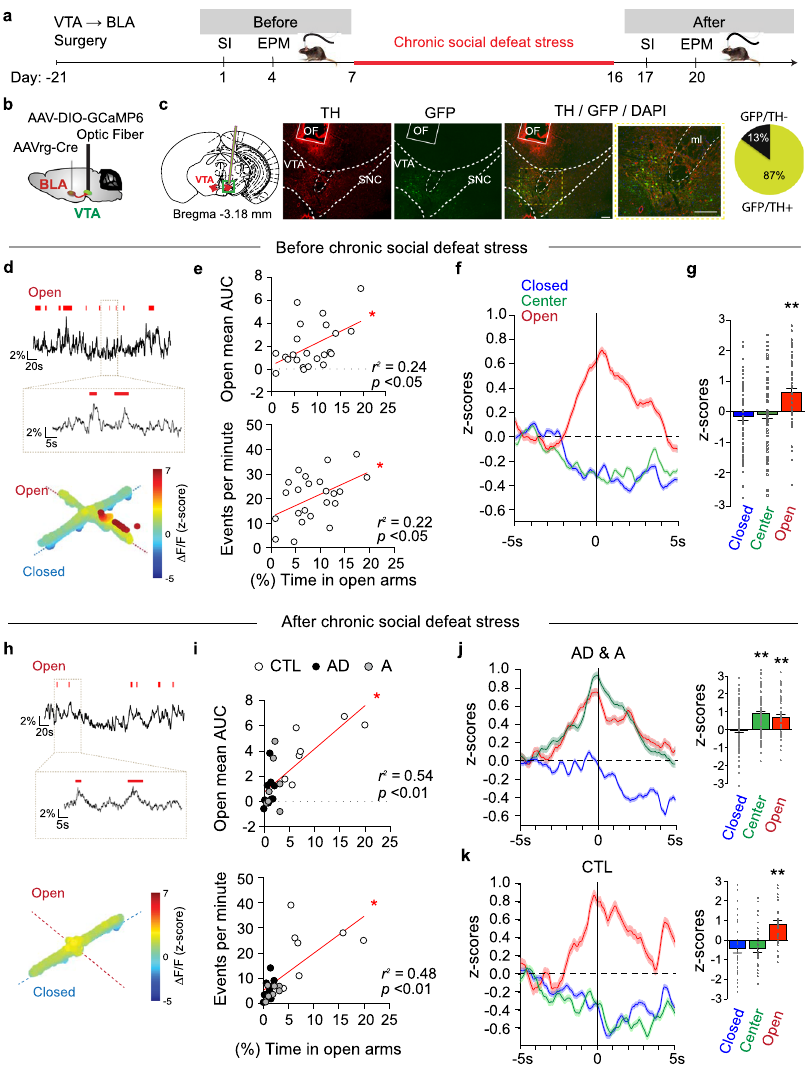
Fig. 3 Anxiety-like behavior is associated with the dynamics of VTA → BLA neurons. a Experimental timeline. b Schematic of the brain surgery targeting the VTA → BLA circuit. c Confocal image showing morphological validation of the placement of the optic fi ber (OF) above the VTA and the co-expression of TH labeling with AAVrg-Cre-eYFP X AAV-DIO-GCaMP6 in the C57BL6/J mouse VTA (scale bar, 100 μ m); quanti fi cation shows 87% colocalization (3 – 4 sections per mouse from 3 mice). d – g Before CSDS. d (Top) Sample traces of GCamp6 Δ F / F signal (bars represent the mouse in open arms). (Bottom) 3D representation of the GCamp6 Δ F / F upon the mouse position within the EPM. e Correlation analyses of the time spent in EPM open arms with (top, Pearson, p = 0.02) the mean open arms AUC VTA → BLA activity and (bottom, Pearson, p = 0.02) with the number of events per minute ( n = 23 mice, examined across 3 independent replicated experiments). f Dynamics of GCamp6 signal (mean z -scores ± s.e.m.) 5 s before and 5s after the mice enter EPM closed arms, center and open arms. g Averaged GCamp6 z -scores across stress-naïve mice within a 1-s bin ( − 0.5 to + 0.5 s) time-locked to EPM closed arms, center or open arms entries (mean ±s.e.m., ANOVA, F 2/276 = 10.94 p = 2.6e − 05; t = 4.32 p = 2.4e − 05; t = 3.88 p = 1.7e − 04, n = 80, 98,100 epochs). h – k After CSDS. h (Top) Sample traces of GCamp6 Δ F / F signal (bars represent the mouse in EPM open arms). (Bottom) 3D representation of the GCamp6 Δ F / F upon the mouse position within the EPM. i Correlation analyses of the time spent in EPM open arms with the mean open arms AUC VTA → BLA activity (top, Pearson, p = 0.001) and with the number of events per minute (bottom, Pearson, n = 23 mice, p = 0.0002). j (Left) Dynamics of GCamp6 signal (mean z -scores ± s.e.m.) 5 s before and 5 s after the socially stressed mice enter in EPM closed arms, center and open arms and (Right) related averaged GCamp6 z -scores across socially stressed mice within a 1-s bin ( − 0.5 to + 0.5 s) time-locked to EPM closed arms, center or open arms entries in socially defeated mice (mean± s.e.m., ANOVA, F 2/188 = 11.79 1.5e − 05; t = 4.71 p = 0.001; t = 3.25 p = 0.003, n = 46, 65, 79 epochs). k Same as j in stress-naïve CTL mice (mean± s.e.m., ANOVA, F 2/92 = 10.59 p = 4.4e − 05, t = 4.11 p = 0.001; t = 3.9 p = 0.001; n = 30, 30, 35 epochs). In all panels, two-sided statistical analyses and corrected post hoc tests were performed, * p < 0.05, ** p < 0.01. See also Supplementary Figs. 4 and